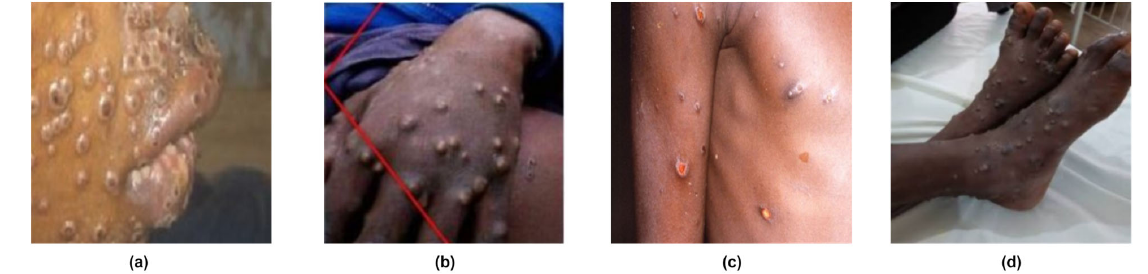
Figure 1. Mpox rash in the face ( a ), hand ( b ), shoulder ( c ), and feet ( d ) [7].